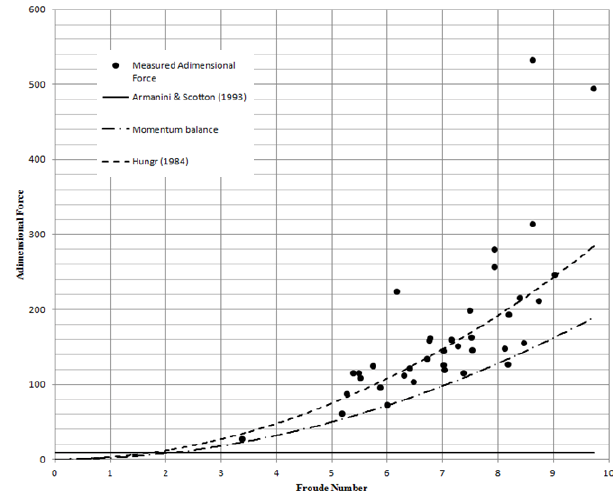
Fig. 4. Trend of the dimensionless force measured in function of the Froude number for barriers positioned orthogonal to the bottom of the channel.